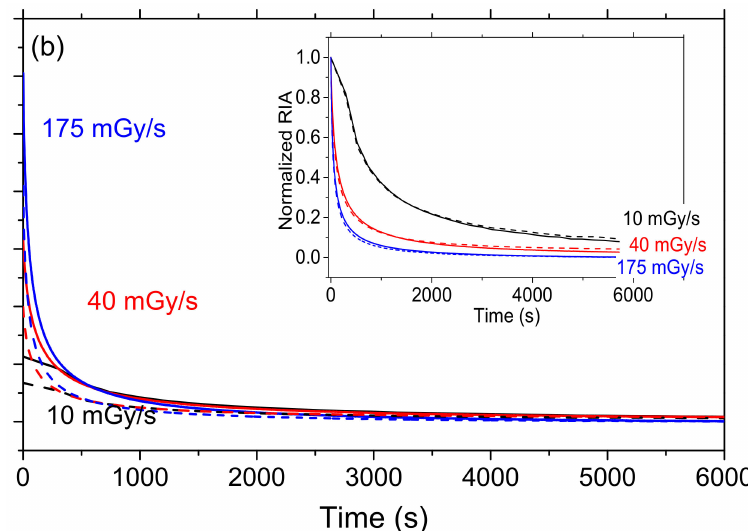
Figure 5. ULL-PSC RIA kinetics ( a ) as a function of the dose during the irradiation and ( b ) as a function of the time during the recovery, at 1310 nm (continuous lines) and 1550 nm (dashed lines), up to TID of 2 kGy, for three dose-rates: 10 (black curves), 40 (red curves), and 175 mGy / s (blue curves—results already reported in Figure 4). In the inset, normalized RIA during the recovery